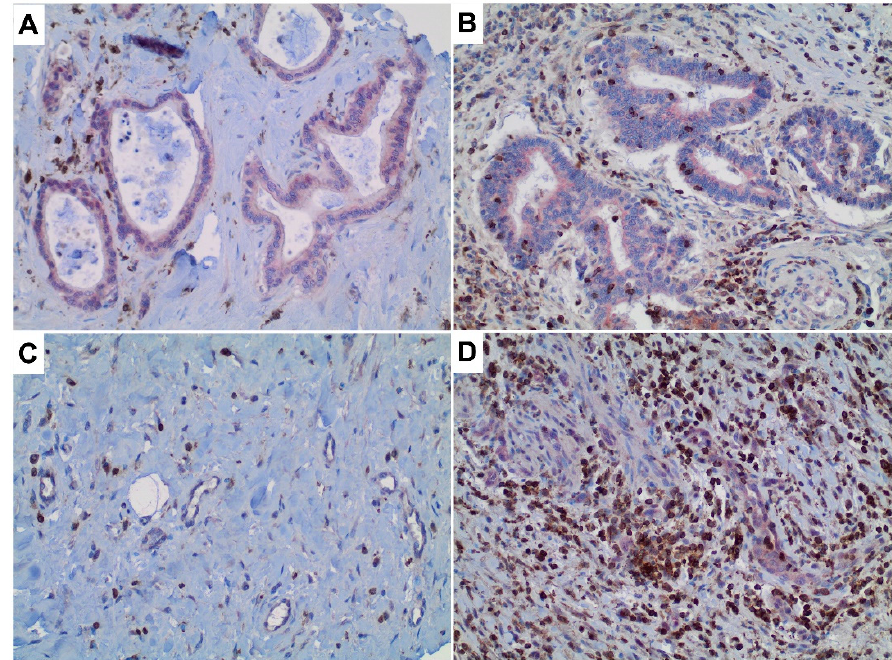
Figure 1. TIRC7 + immune cells in cholangiocarcinoma. Photographs of both a low ( A ) and particularly high ( B ) intraepithelial TIRC7 + immune cell density and low ( C ) and particularly high ( D ) numbers of TIRC7 + cells in the stromal compartment. Displayed are tumor samples. Note that the photographs were used for visualization and as such do not represent the expression average. Original magnification: 200×.